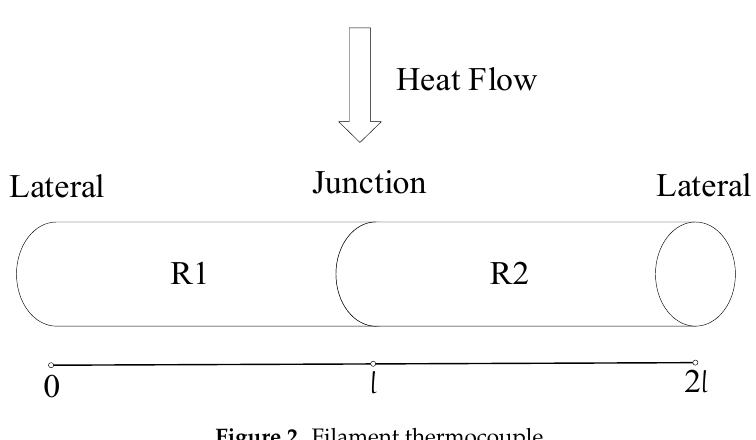
Figure 2. Filament Figure 2. Filament thermocouple.